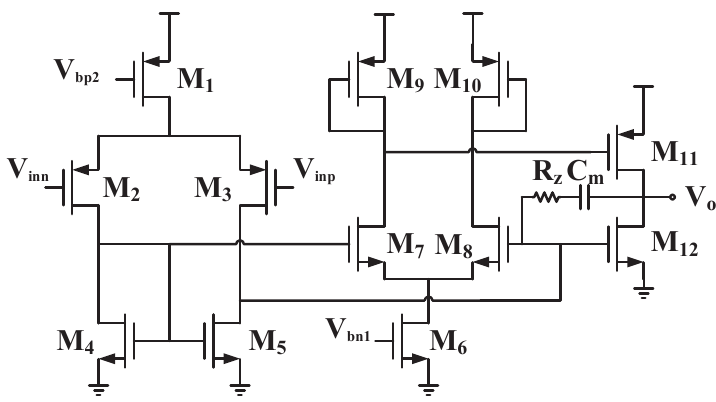
Figure 8. Schematic of output